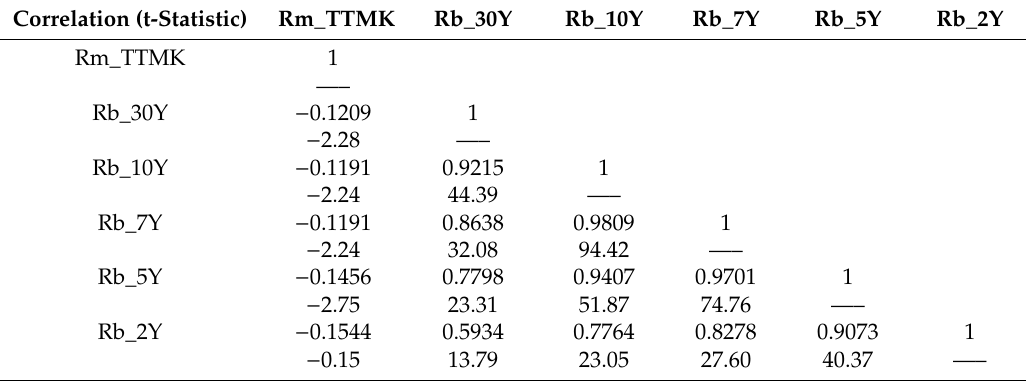
Table 1. Correlation matrices of stock returns, bond returns, risk, and